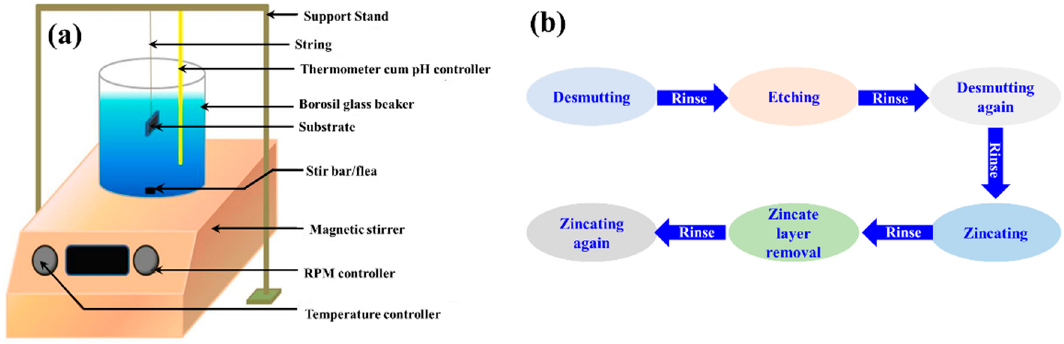
Figure 1. Schematic diagram illustrating the ( a ) experimental set-up and ( b ) the procedure for the electroless deposition process.